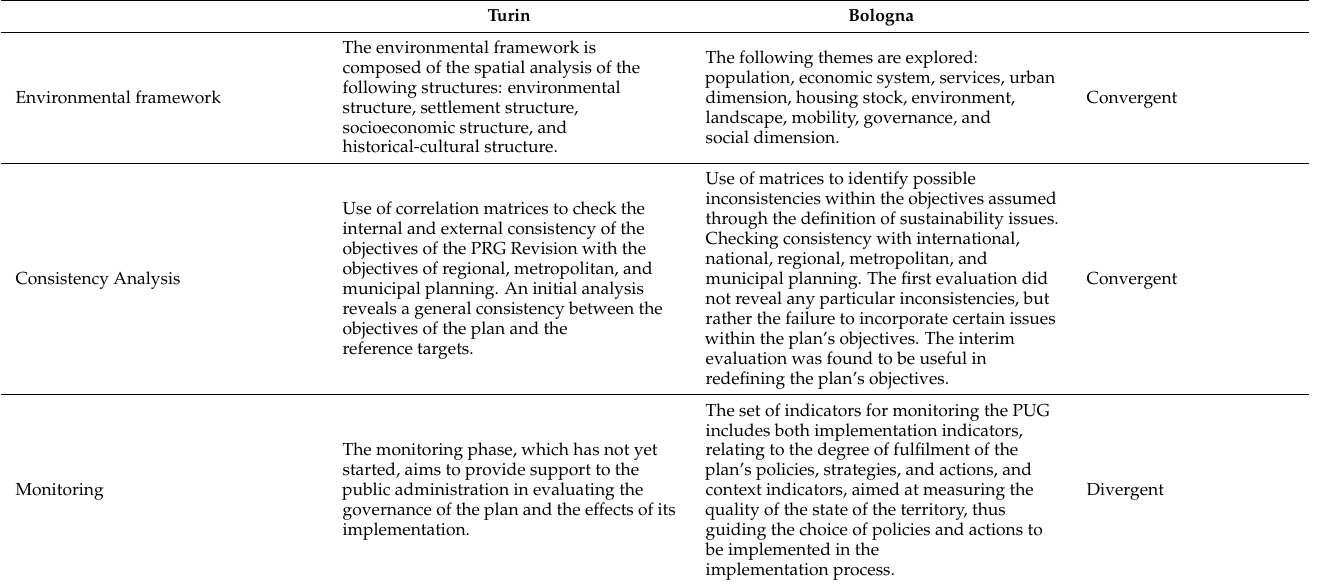
Table 2. Comparison between the strategic environmental assessment procedures of Turin and